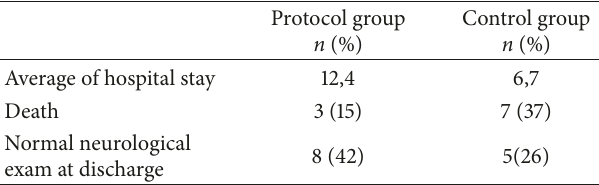
Table 4: Evolution during hospitalization.